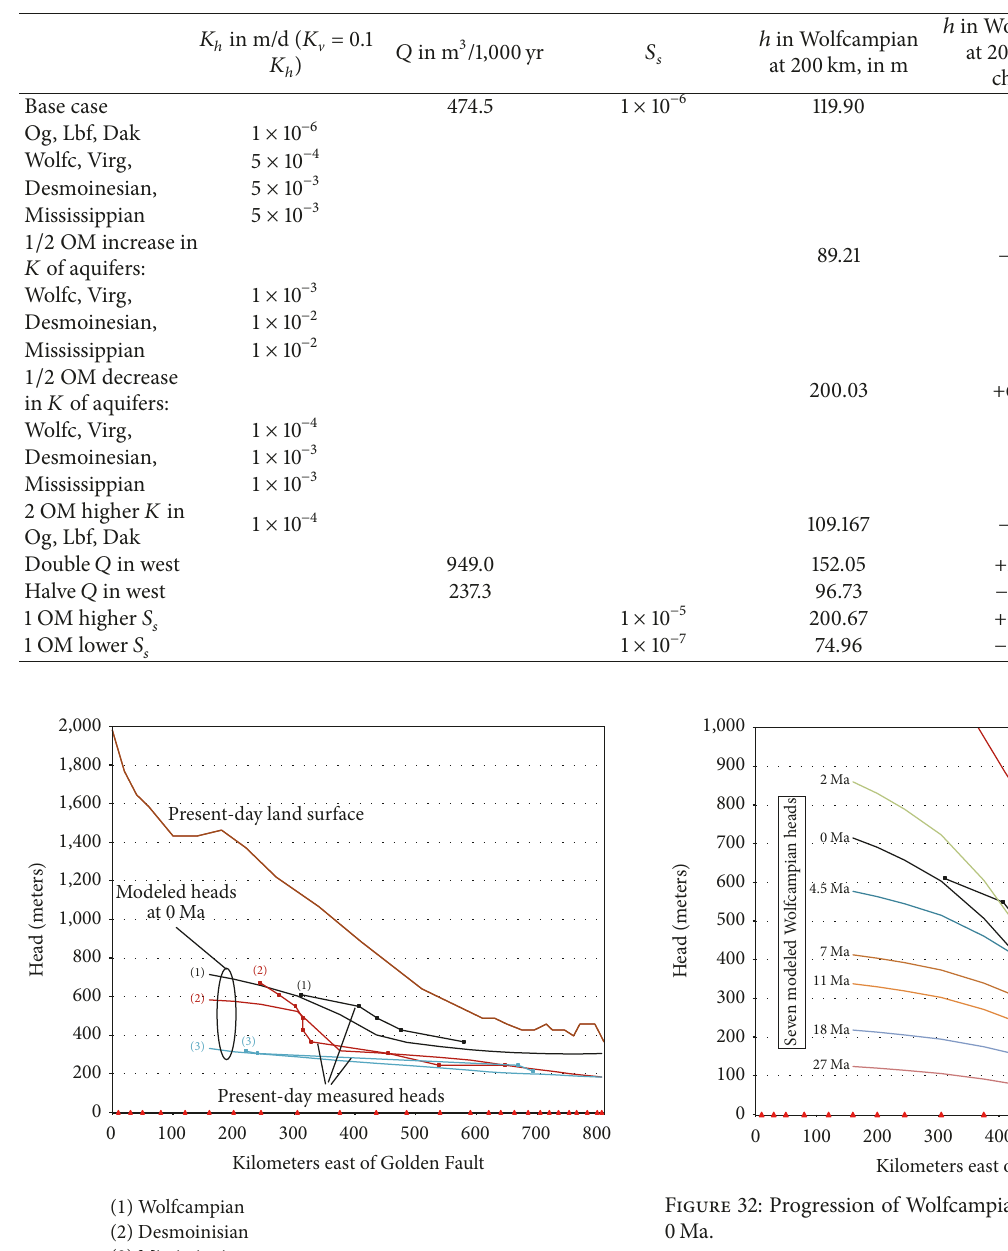
Table 7: Sensitivity analysis (OM: order of magnitude, Og: Ogallala, Lbf: Laramide Basin Fill, Dak: Dakota, Wolfc: Wolfcampian, Virg: Virgilian).